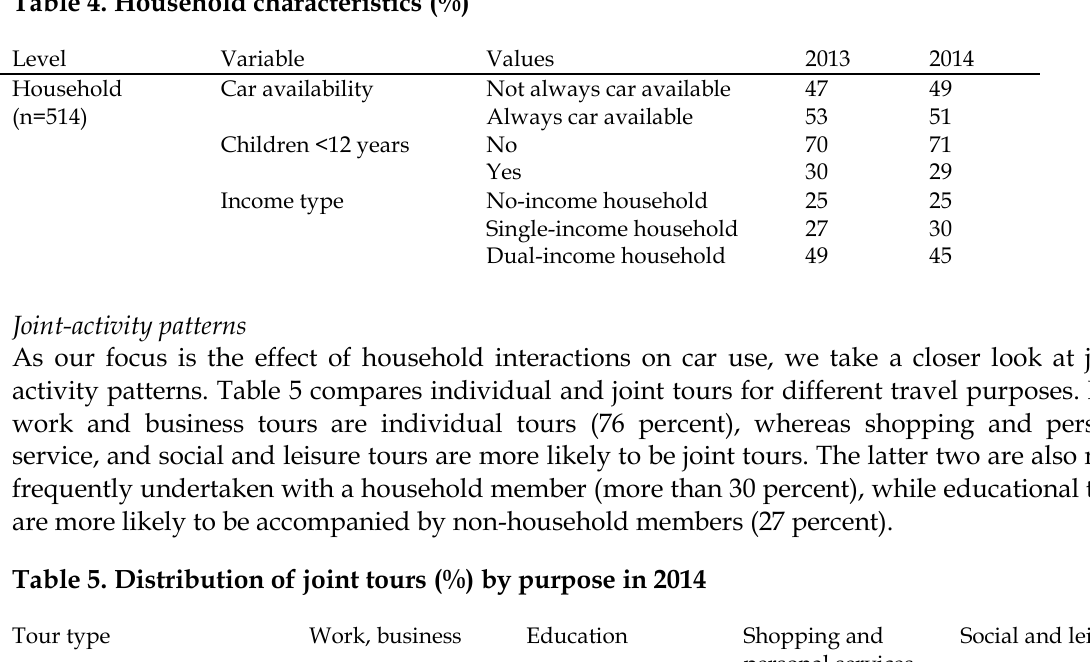
Table 4. Household characteristics (%)